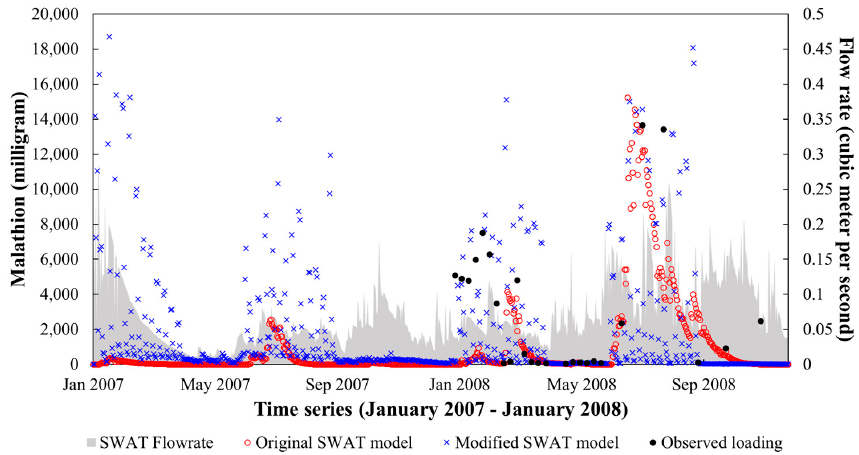
Figure 8. Time series of malathion loading simulated by the original SWAT and the modified SWAT models, observed malathion loading at the Lucban Station, and SWAT simulated flowrate.